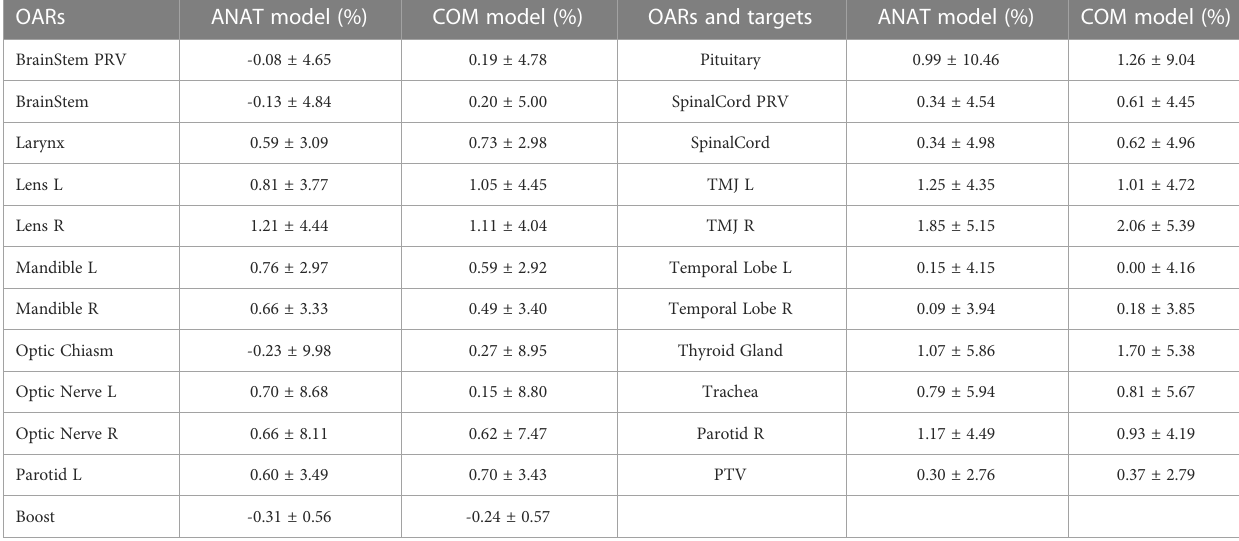
TABLE 2 Comparison of the ME for each OAR and